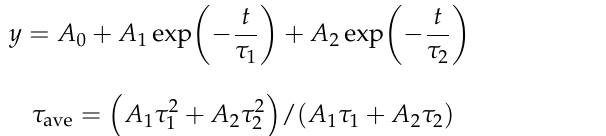
Figure 5 displayed the normalized time-resolved PL decay curves of as-prepared films.